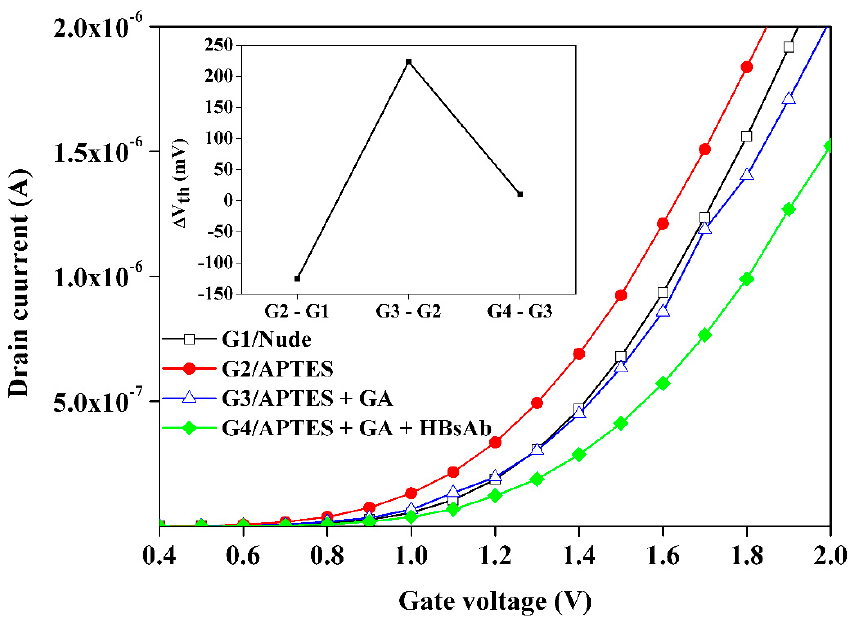
Figure 3. The electrical properties of pSiNWFET following each step of surface modification and HBsAb immobilization. I D –V G linear graph was analyzed from nude (G1), treated with APTES (G2), APTES + GA (G3), and APTES + GA + HBsAb (G4). The inset figure showed the changes of threshold voltage following each step of surface modification.